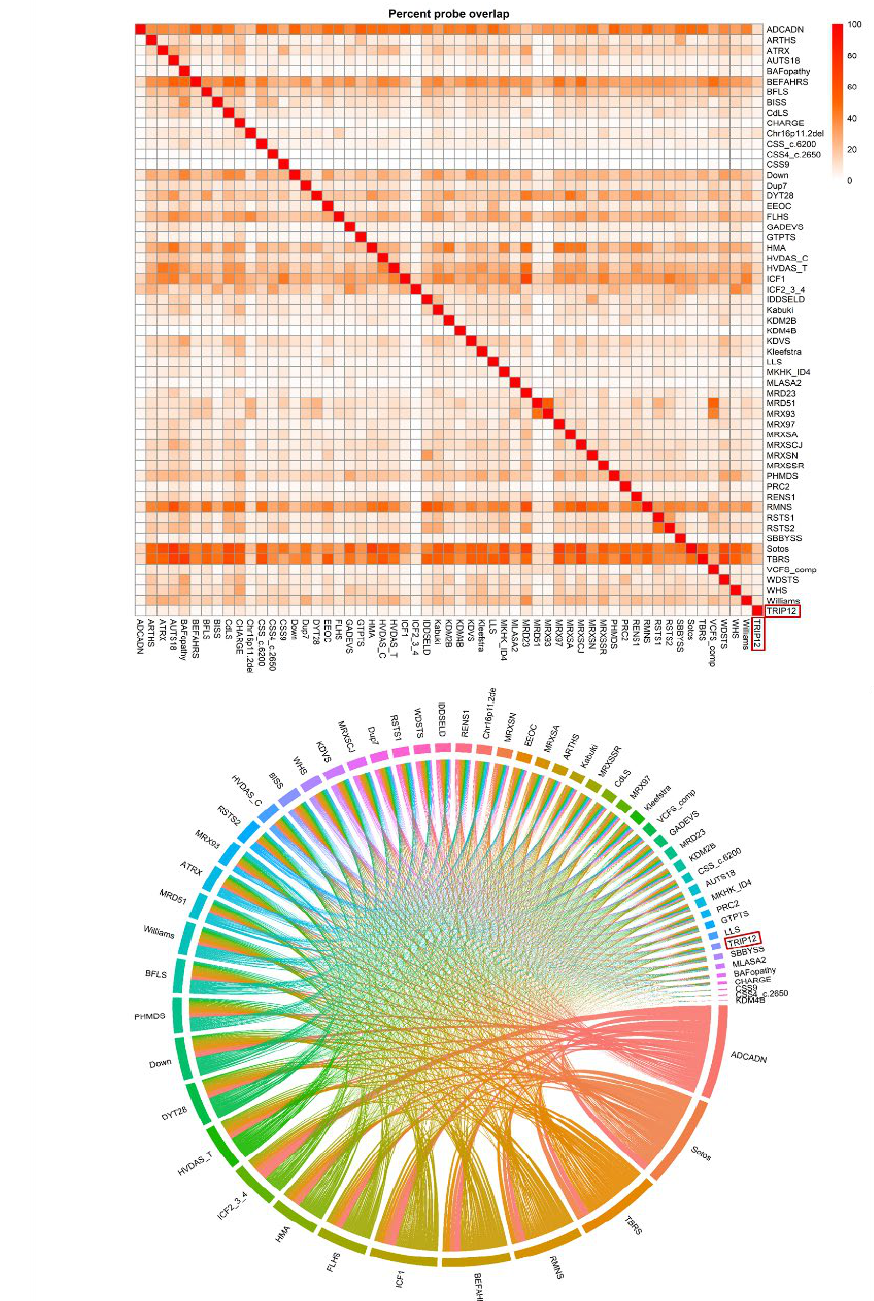
Figure 6. Differentially methylated probes (DMPs) shared between the TRIP12 cohort and 56 other EpiSign™ disorders with known episignatures: ( a ) heatmap showing the percentage of probes shared between each paired cohort. Colors indicate the percentage of the y-axis cohort’s probes that are also found in the x-axis cohort’s probes. ( b ) Circos plot representing the probes shared between each pair of cohorts. The thickness of the connecting lines indicates the number of probes shared between the two cohorts. Abbreviations are listed in Supplementary Table S3.